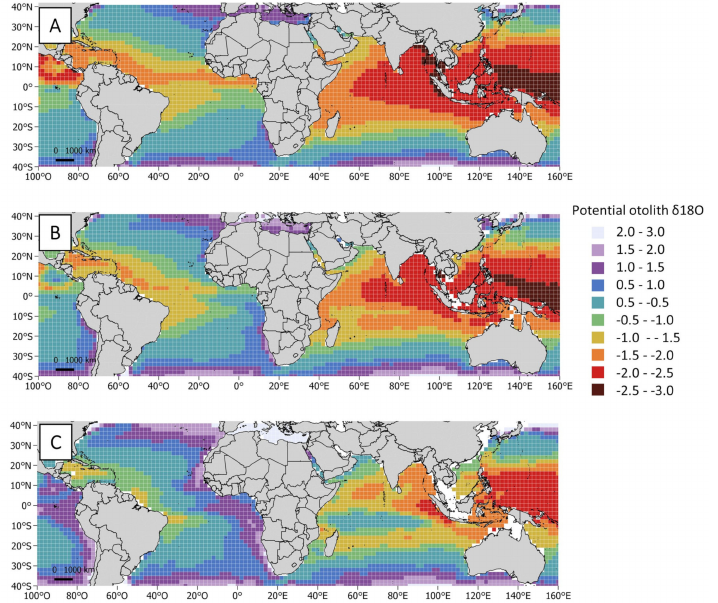
Figure 5. Isoscape of predicted δ 18 O composition in otoliths based on global surface water measured δ 18 O values [35] at 0–20 m ( A ), 20–50 m ( B ) and 50–100 m ( C ), using the equation T = γ ( δ 18 O δ 18 O β [39] and parameters γ and β from [37]. Data were averaged at each 1 ◦ × 1 ◦ WATER ) +